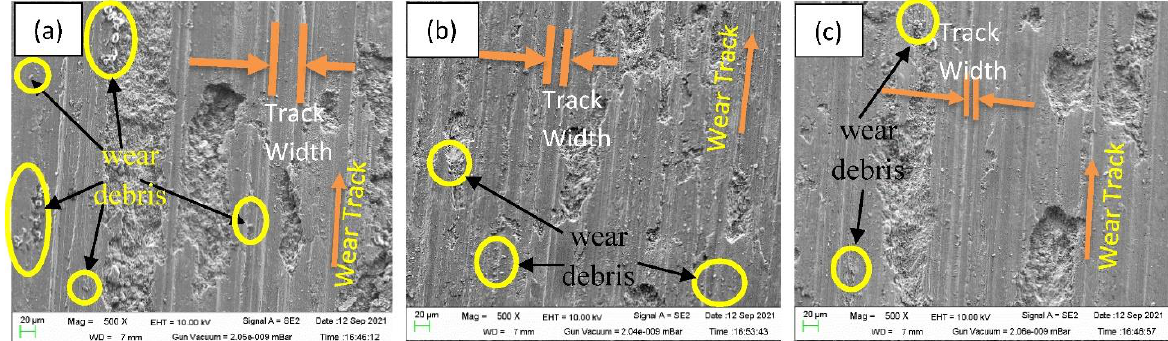
Figure 12. Wear track and width morphologies of different specimen: ( a ) AF9C, (b) AF12C, and ( c ) AF15C.